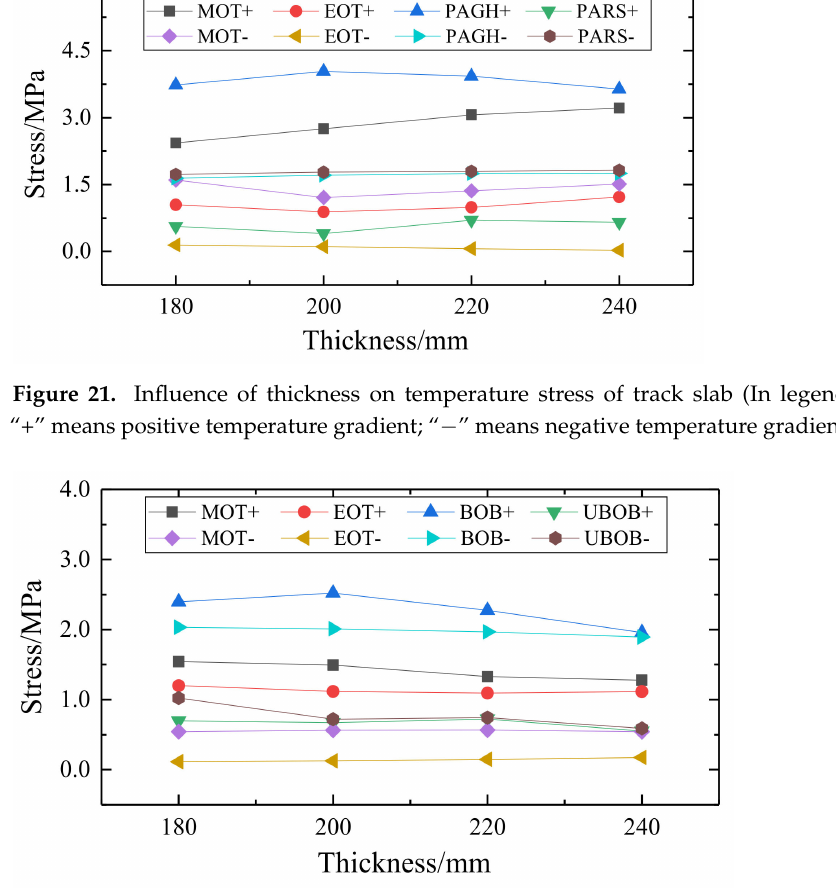
Figure 22. Influence of thickness on temperature stress of adjustment layer (In legend identification, “+” means positive temperature gradient; “ − ”means negative temperature